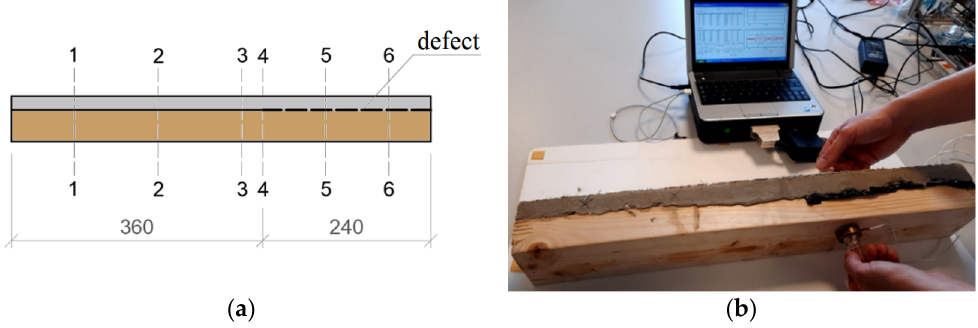
Figure 4. ( a ) Placement of measurement points along the specimen length; ( b ) process of ultrasound testing.